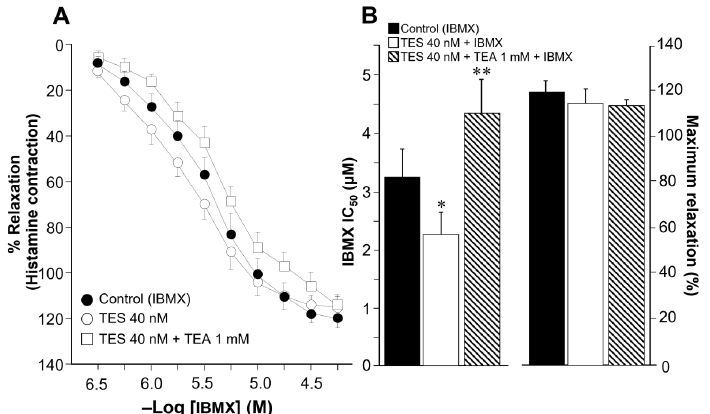
Figure 2. Isobutylmethylxanthine (IBMX) induces guinea pig tracheal smooth muscle relaxation, which is enhanced by chronic exposure to testosterone (TES), while acute treatment with tetraethylam- monium (TEA) abolishes the enhancement, suggesting that K + channels are involved in TES action. ( A ) Cumulative concentration curve of IBMX relaxes tracheal rings precontracted with histamine (10 µ M). After 48 h of preincubation of tracheal rings with TES (40 nM, n = 6), the concentration- response curve to IBMX was significantly shifted to the left. This TES effect was abolished by acute addition (10 min) of 1 mM TEA, a non-selective K + channel blocker. ( B ) The bar graph shows that TES decreases the inhibitory concentration by 50% (IC 50 ) of IBMX compared with the control group, while TEA 1 mM increases this parameter, indicating the involvement of K + channels in IBMX relaxation and testosterone effects. Maximal relaxation was not altered by TES treatment. Symbols and bars represent mean ± S.E.M., * p < 0.05, ** p < 0.01. Repeated measure analyses of variance were performed, followed by Dunnett’s multiple comparison